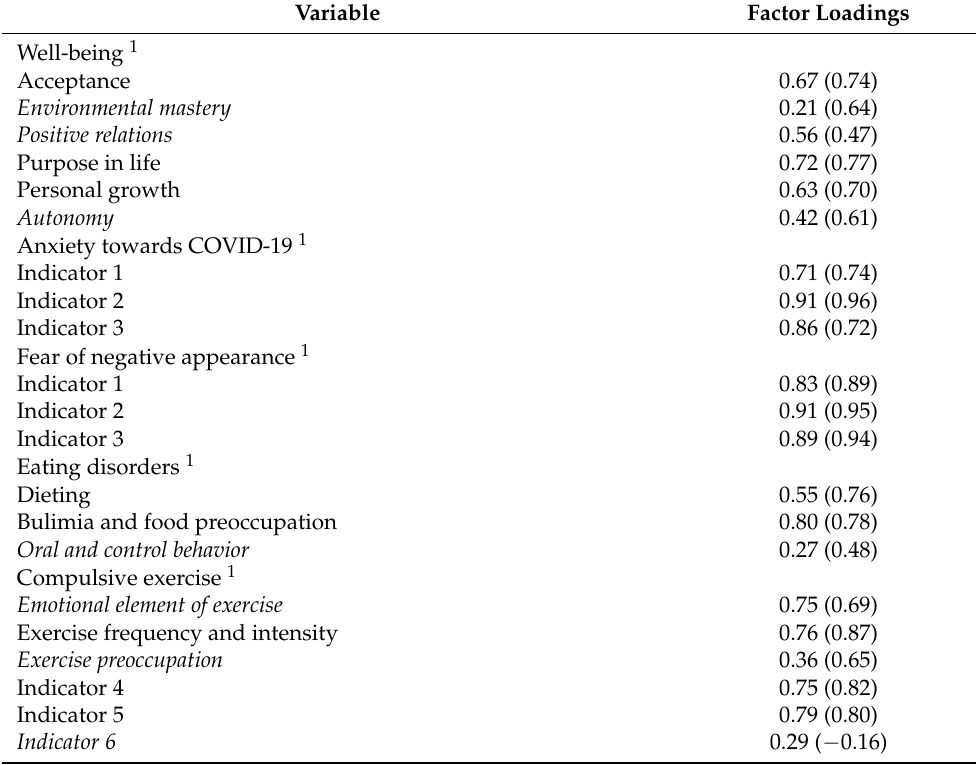
Table 2. Factor loadings of all